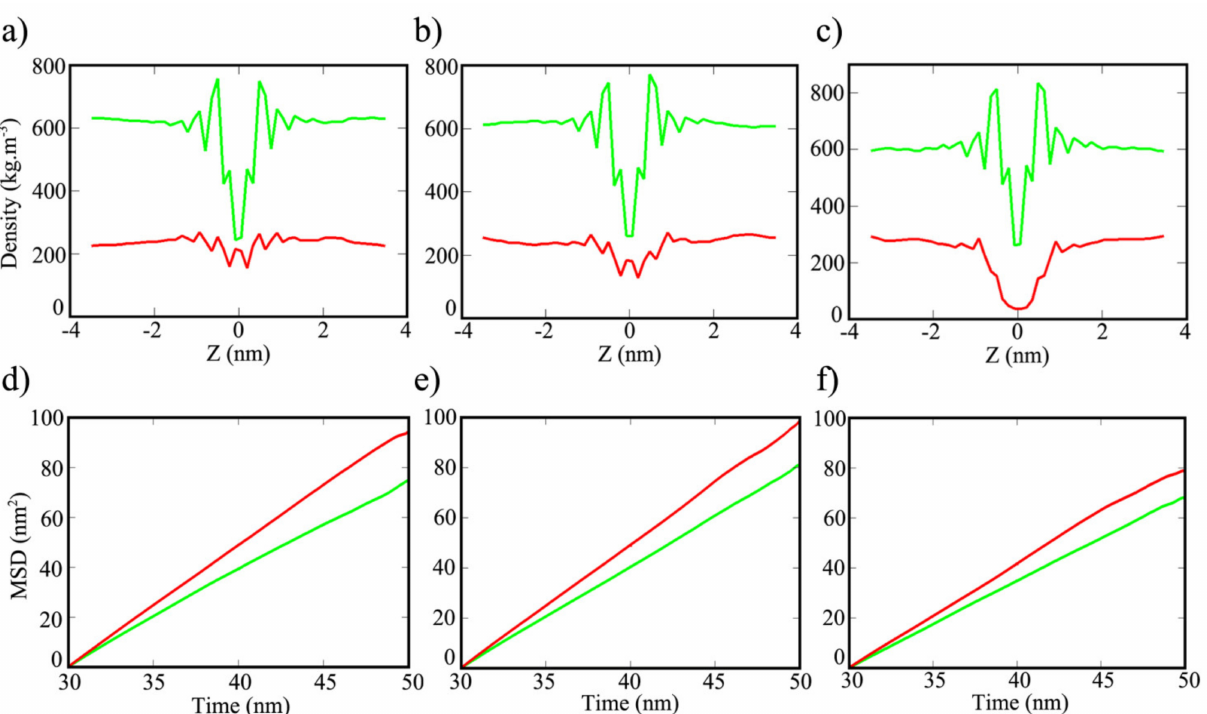
Figure 10. Density profiles of the center of mass for water (red lines) and ethanol (green lines) on ( a ) COF-1, ( b ) CTF-1 and ( c ) TPG, and MSD diagrams of the ethanol (green lines) and water (red lines) molecules on ( d ) COF-1, ( e ) CTF-1 and ( f )